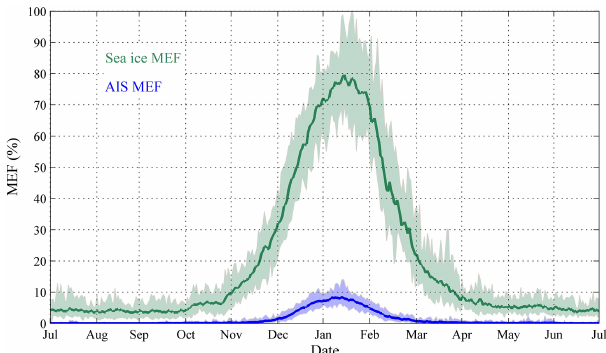
Figure 6. Daily mean Antarctic sea ice MEF and AIS MEF; the corresponding shadows indicate daily maxima and